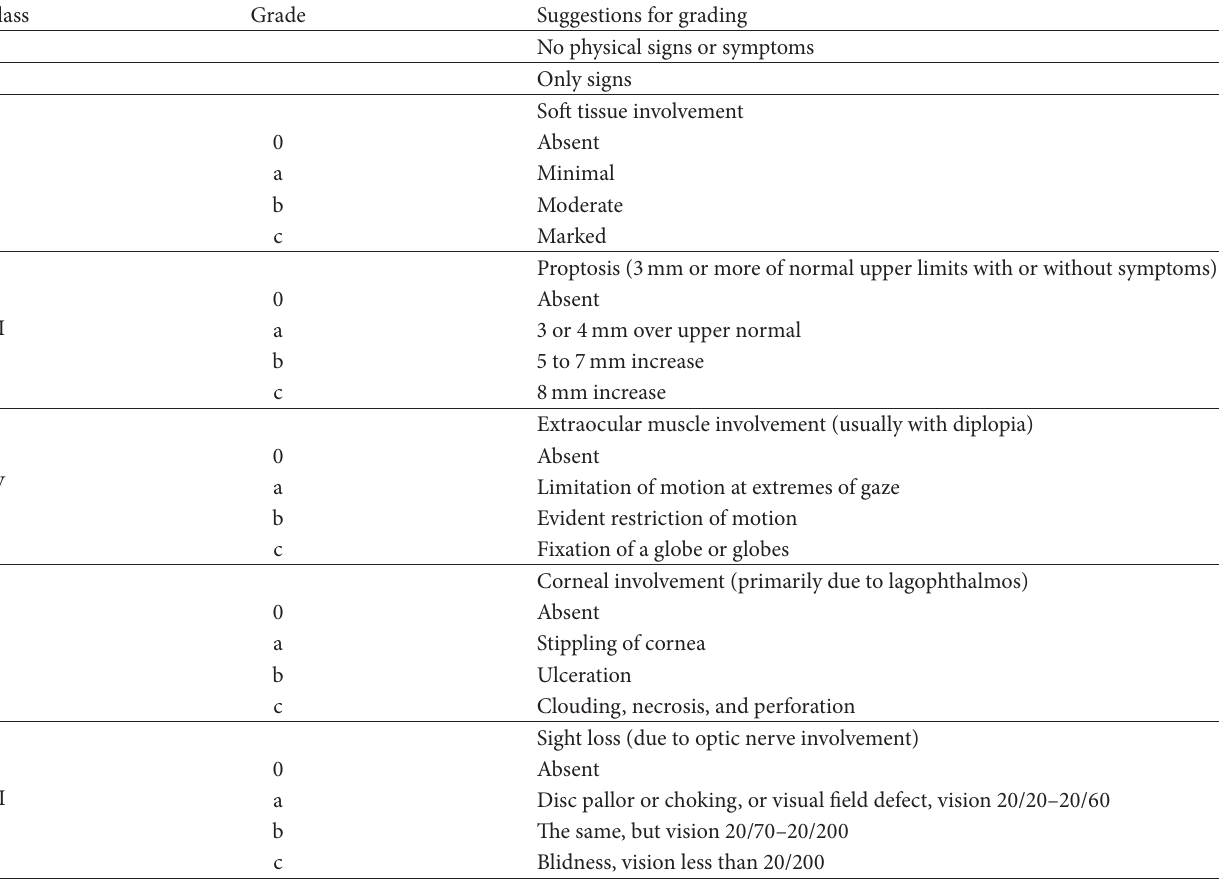
Table 1: NO SPECS modified classification